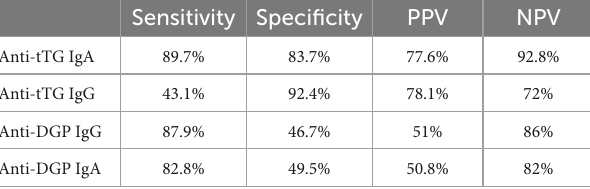
TABLE 3 Performance measures of the tested immunoglobulins compared to the biopsy finding (a gold standard test). Sensitivity Specificity PPV